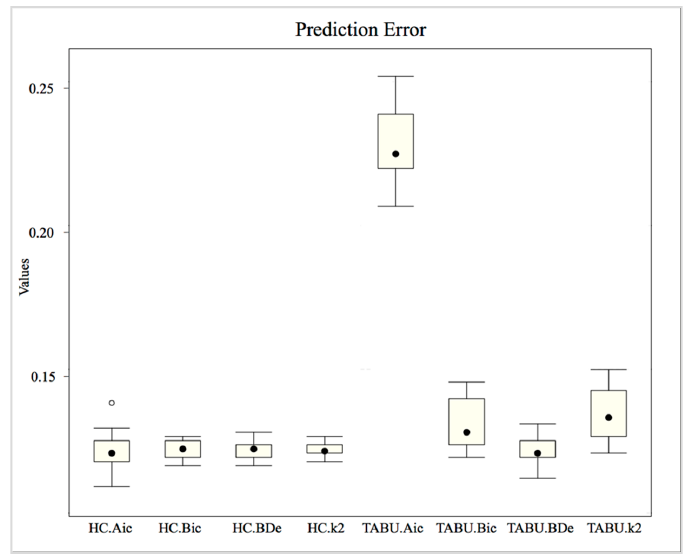
Figure 9. The predictive error of cross-validation using Maximum Likelihood estimation.